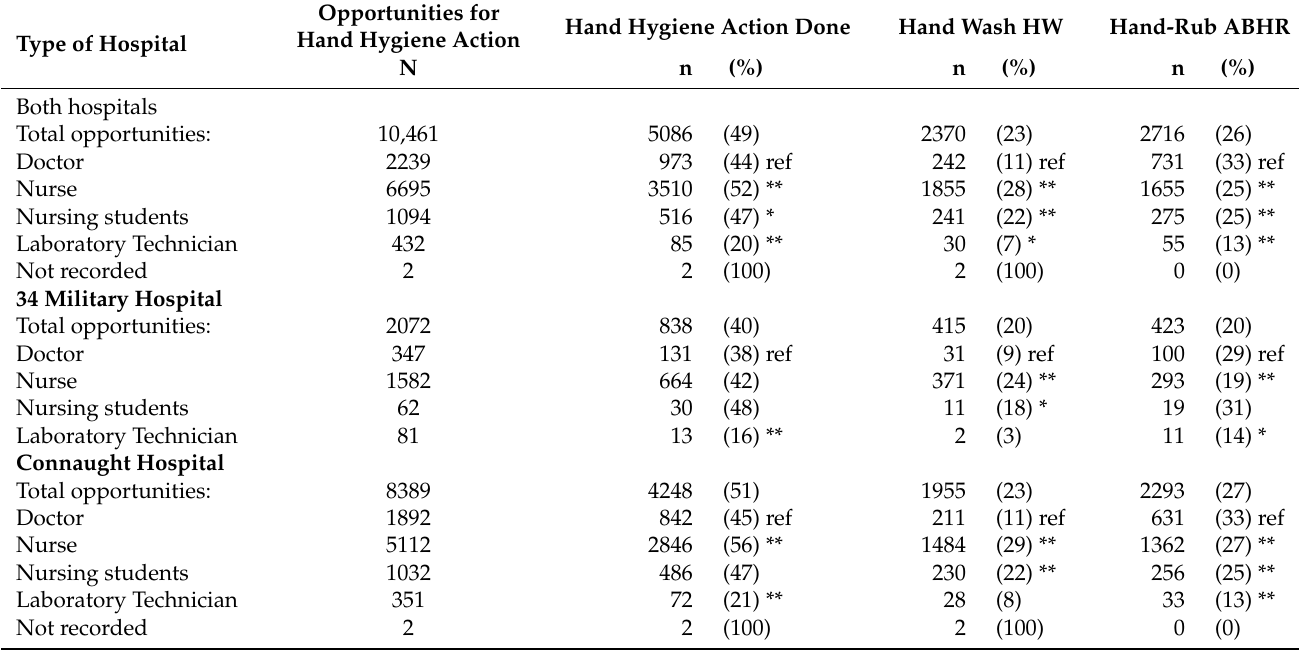
Table 3. Hand hygiene compliance within the two tertiary hospitals in relation to the type of health care worker observed and whether this was hand wash or hand-rub in Freetown, June–August